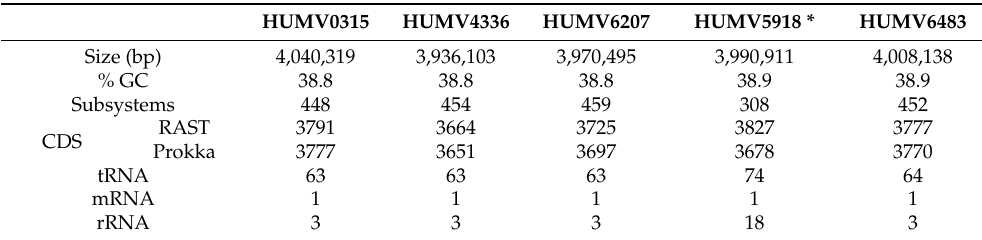
Table 2. Features of A. pittii genomes according to RAST and Prokka annotation. * PacBio sequenced. CDS, coding